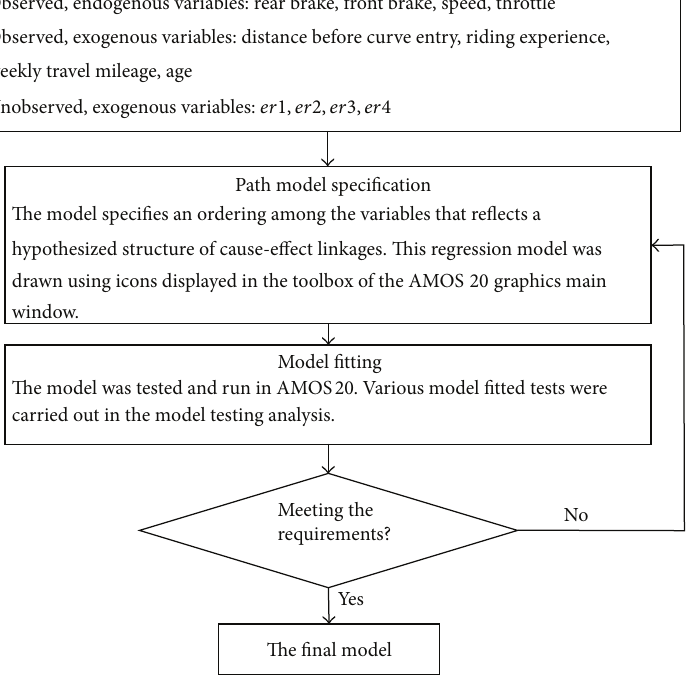
Figure 6: Framework showing the process of the development of SEM for riding behaviour before curve entry.